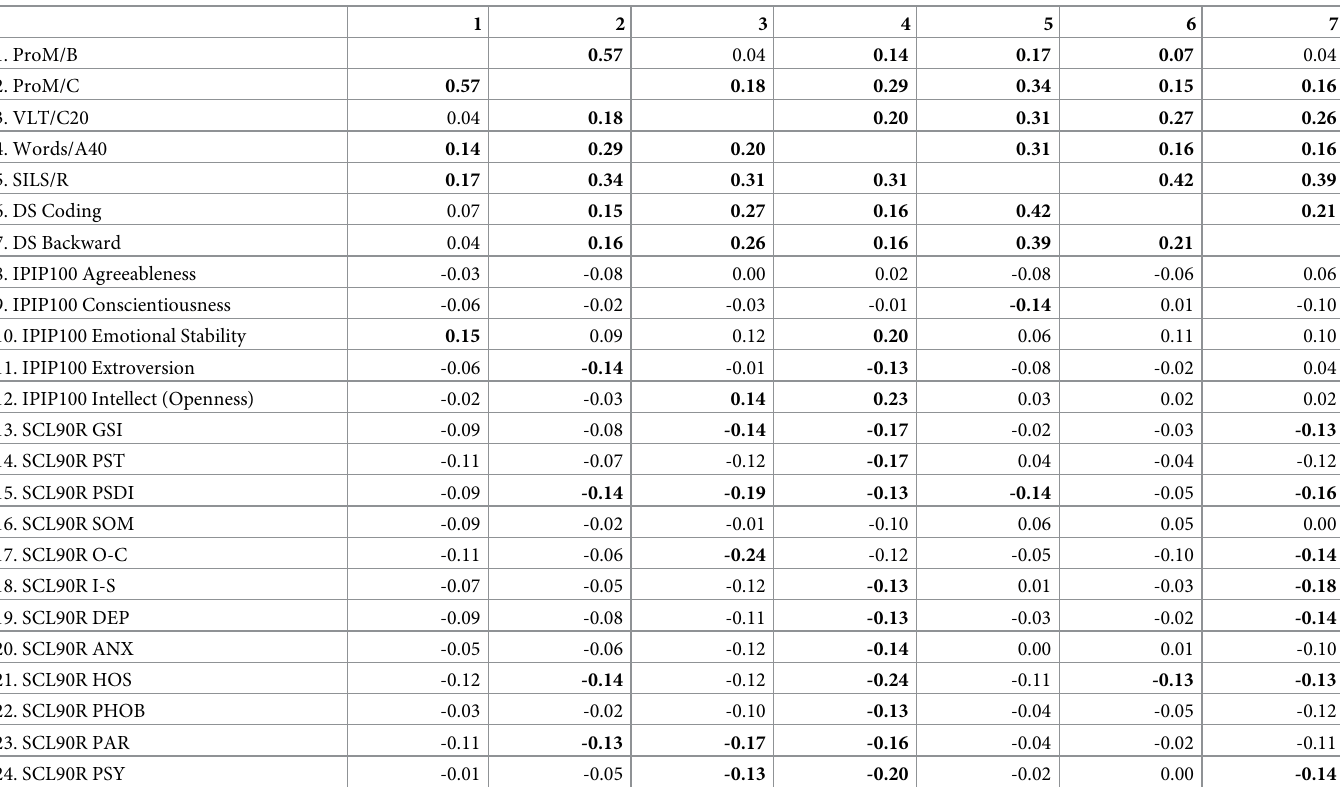
Table 4. Correlation matrix for